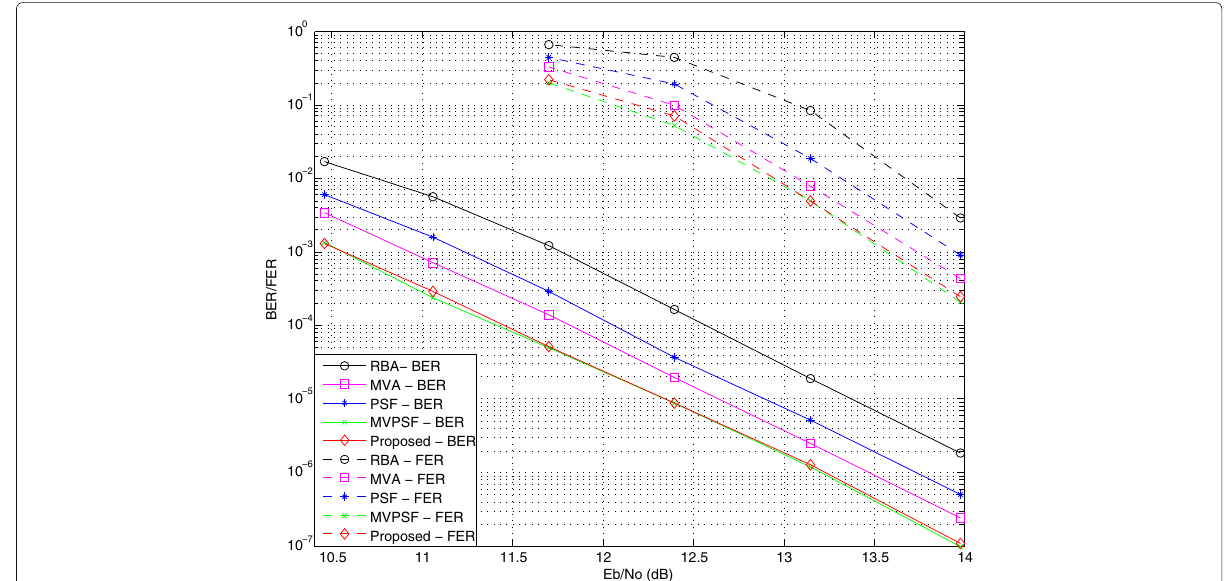
Fig. 4 Comparison of decoder BER performance for 1023 × 781, GF(16) LDPC